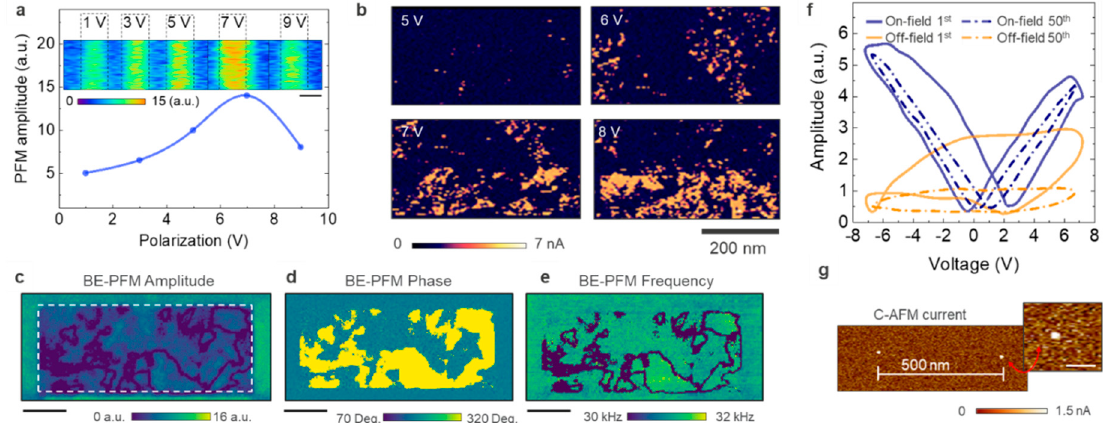
Figure 2. Band-excitation and C-AFM analysis results. ( a ) Non-monotonic dependence of the PFM amplitude response as a function of the dc voltage used for the poling. The inset shows regions polarized at different conditions, visually resulting in the same effect (scale bar 2 µm). ( b ) C-AFM is used to quantify the electronic leakage associated with different dc stress conditions. ( c ) Amplitude ( d ) phase and ( e ) frequency channels of BE-PFM for the 8-nm thick FE-HfO 2 surface after dc polarization at 7 V for two scans inside the area marked by the white dashed line. The topography appears homogeneous within the investigated areas before and after dc polarization (scale bar 400 nm). ( f ), Out-of-plane BE-PFM hysteresis loop for FE-HfO 2 , comparing on-field and off-field response for the first and fiftieth cycles. ( g ) Percolative paths are observed in the location of tip-induced cycling, C-AFM is used to detect the high leakage associated with the spots at 1.5 V bias applied to the sample.